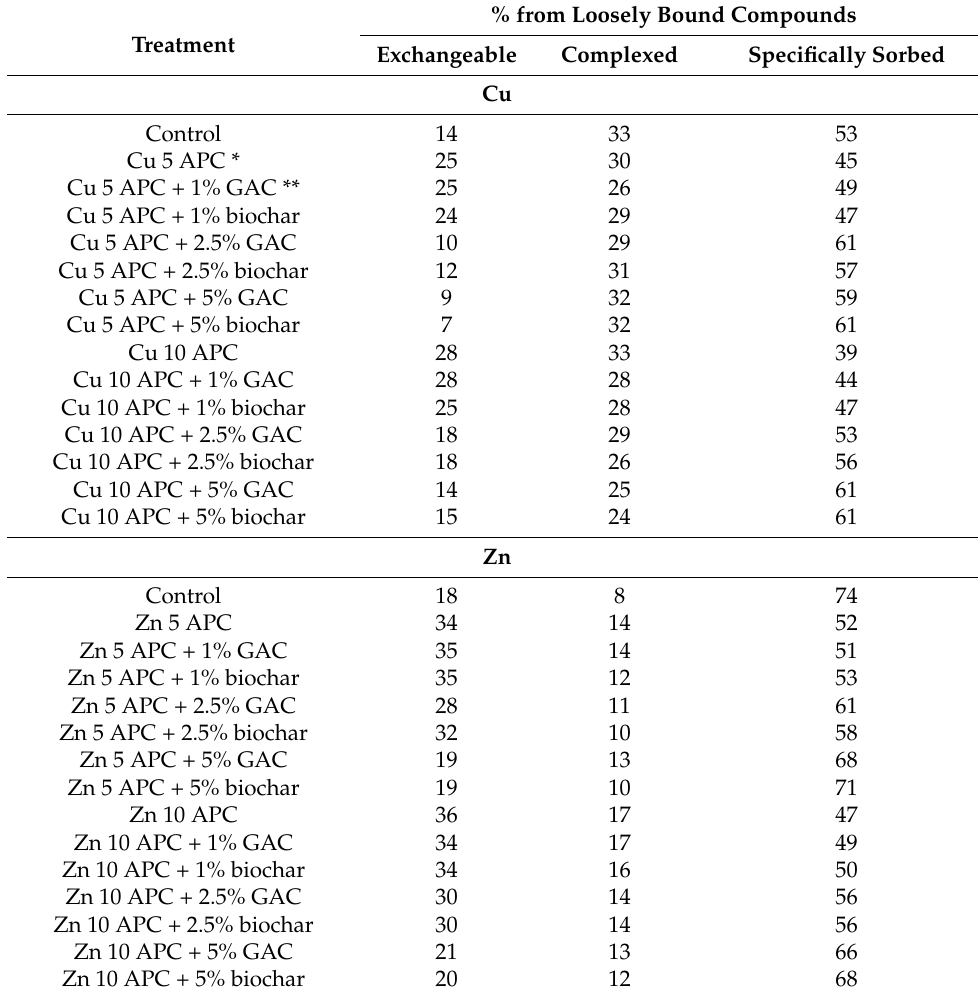
Table 4. The percentage of Cu and Zn in the group of loosely bound compounds. % from Loosely Bound Treatment